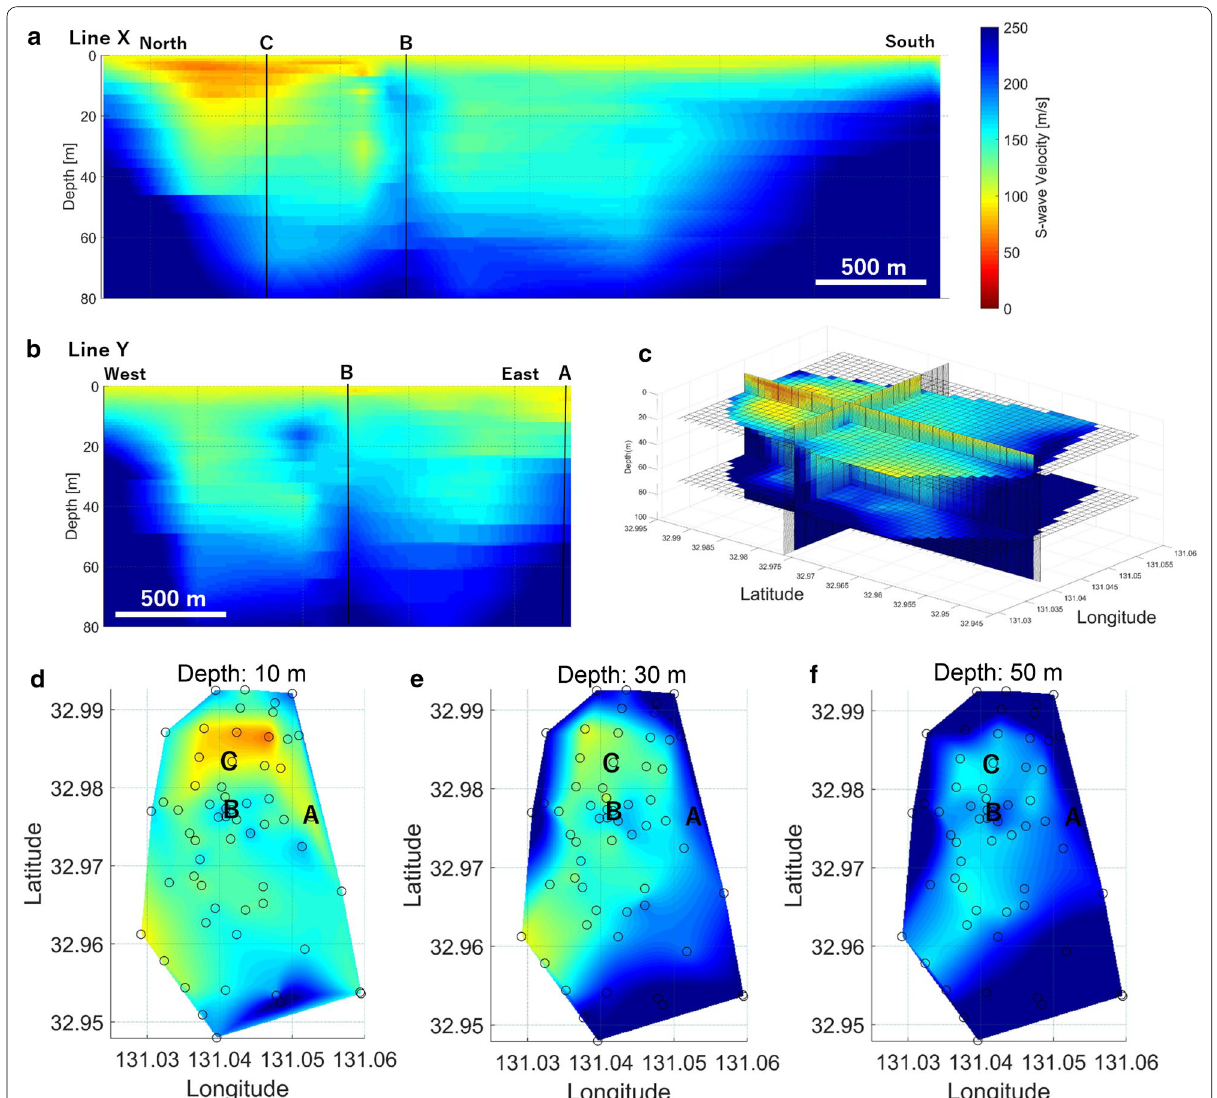
Fig. 3 S-wave velocity–depth profiles of a north–south Line X and b east–west Line Y (see Fig. 1c for locations). c Entire 3D S-wave velocity model constructed by interpolation of velocities estimated at array locations. Depth slices extracted from the 3D S-wave velocity model at d 10 m, e 30